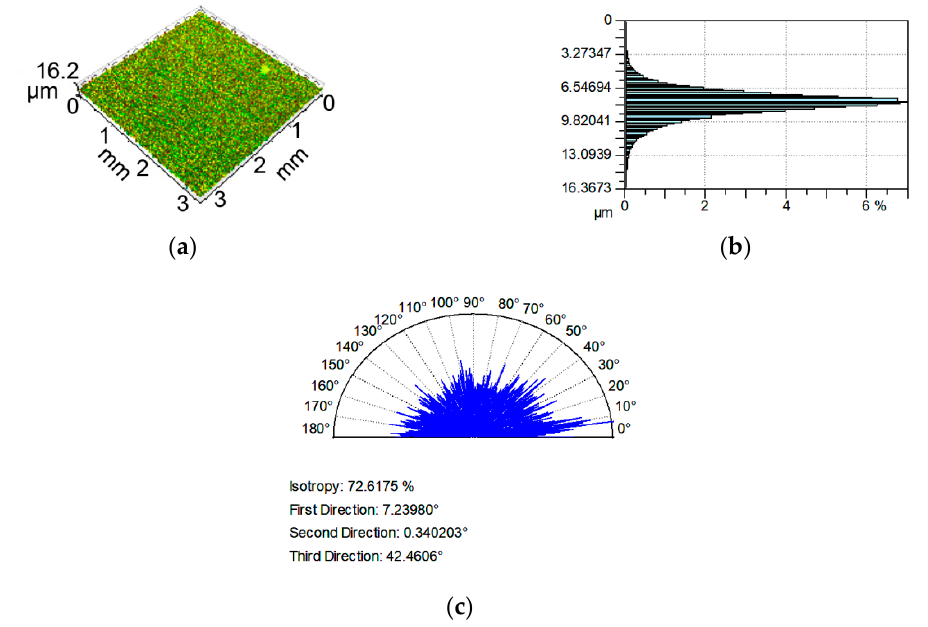
Figure 2. Isometric view ( a ), ordinate distribution ( b ), and directionality plot ( c ) of surface texture after vapor blasting.